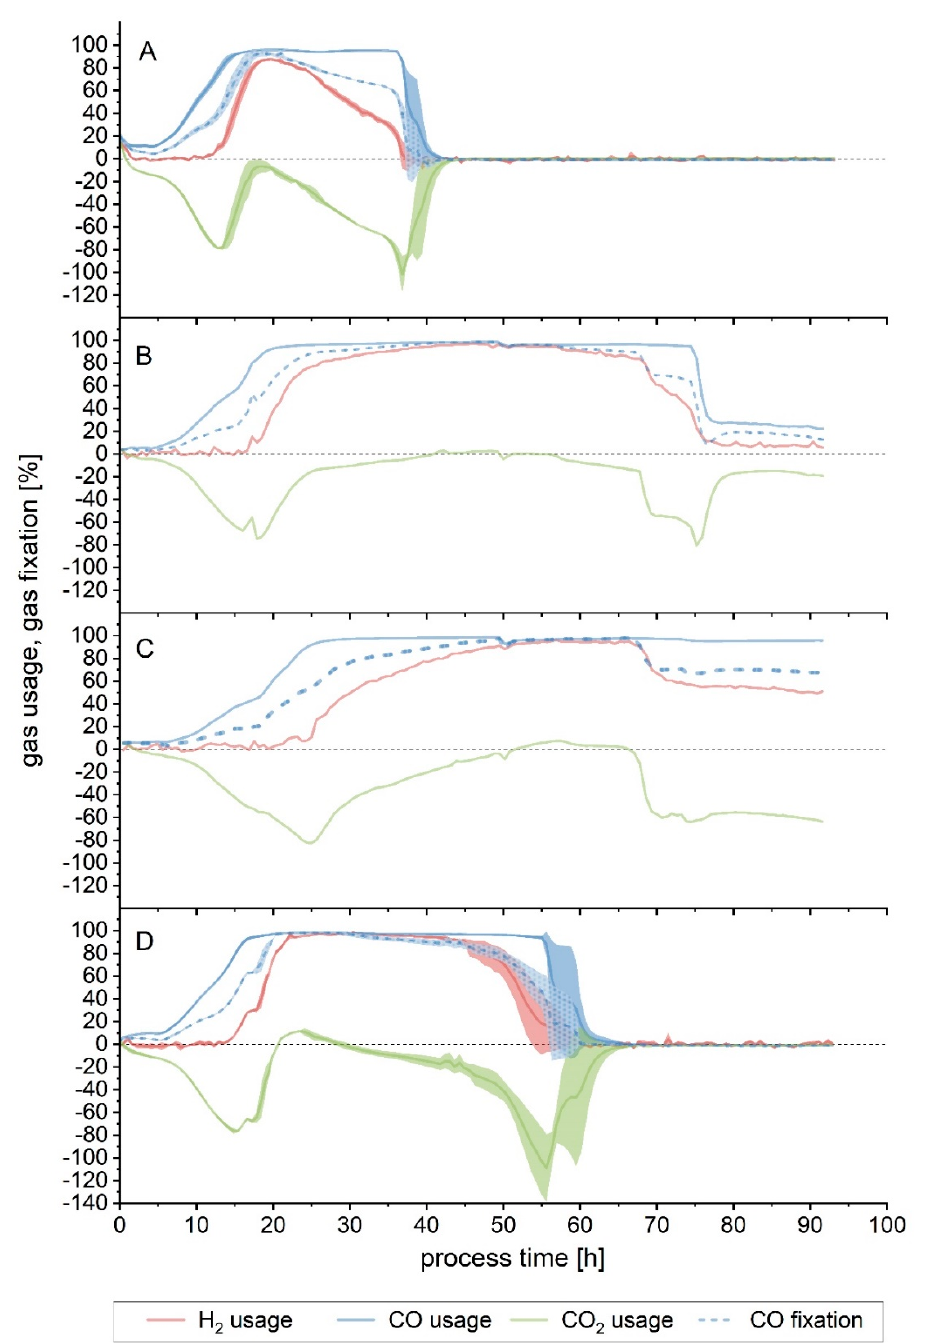
Figure 4. Substrate usage or fixation for: Setup 2 without pH regulation ( A ); Setup 3b with increased cysteine and pH change to 5.4 after 68 h ( B , C ); and Setup 5 with pH allowed to drop to 4.8 after 24 h ( D ). ( B , C ) Each of the individual fermenter profiles is shown due to the divergence observed between them: the second fermenter ( C ) is remarkably delayed. Usage is shown for H 2 (red line), CO 2 (green line) and CO (blue line). CO fixation is depicted by the dotted blue line. Except where otherwise stated, lines show the average of a triplicate ( n = 3), while the lighter colored areas depict the standard deviation.